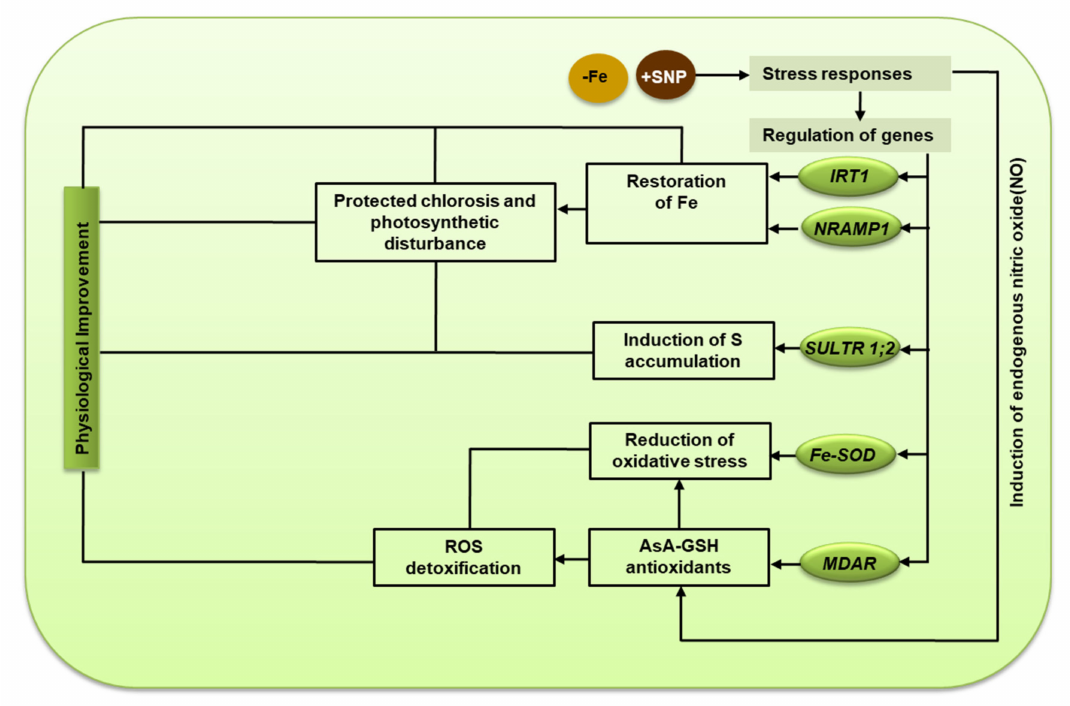
Figure 9. The mechanistic basis of nitric oxide-mediated protection of Fe deficiency-induced chlorosis, photosynthetic disturbance, and oxidative stress in